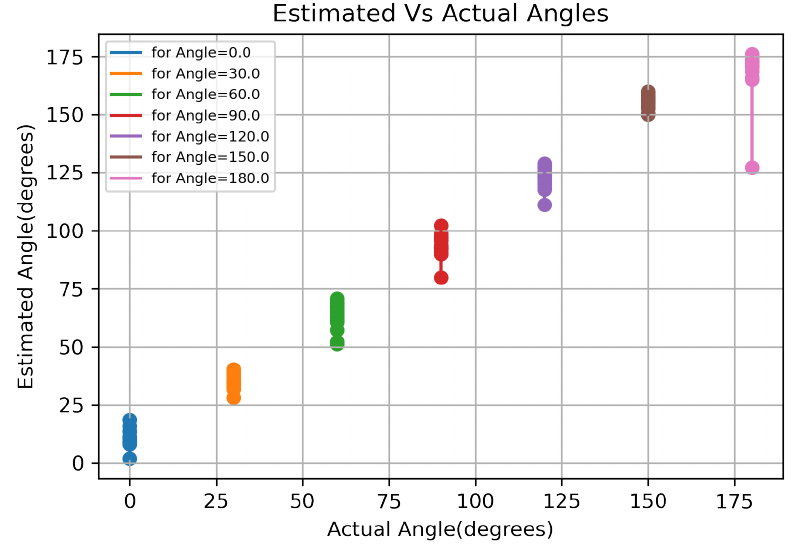
Figure 11. Graph showing estimated value vs. actual value of